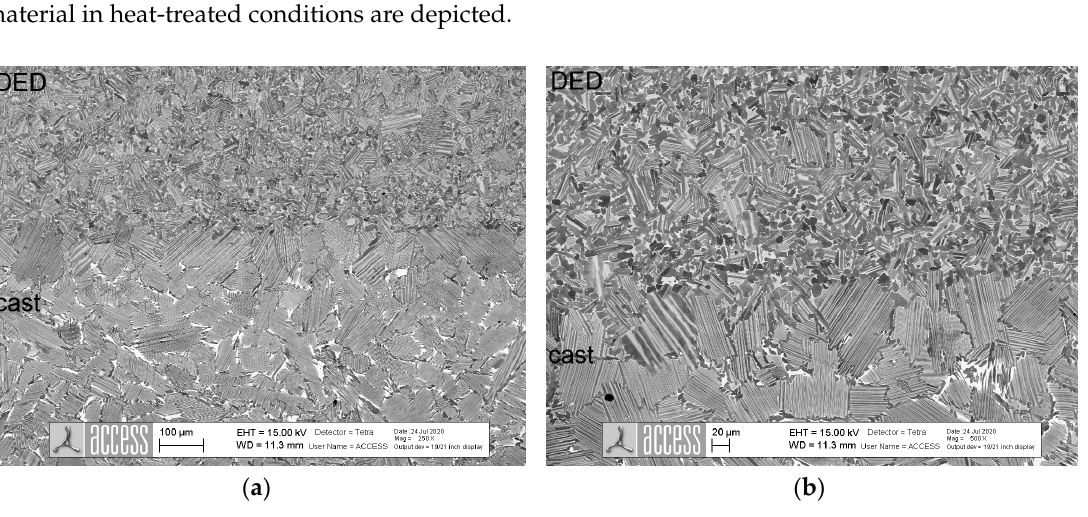
( a ) 100×; ( b ) 500× magnification. ( a ) 100 × ; ( b ) 500 ×